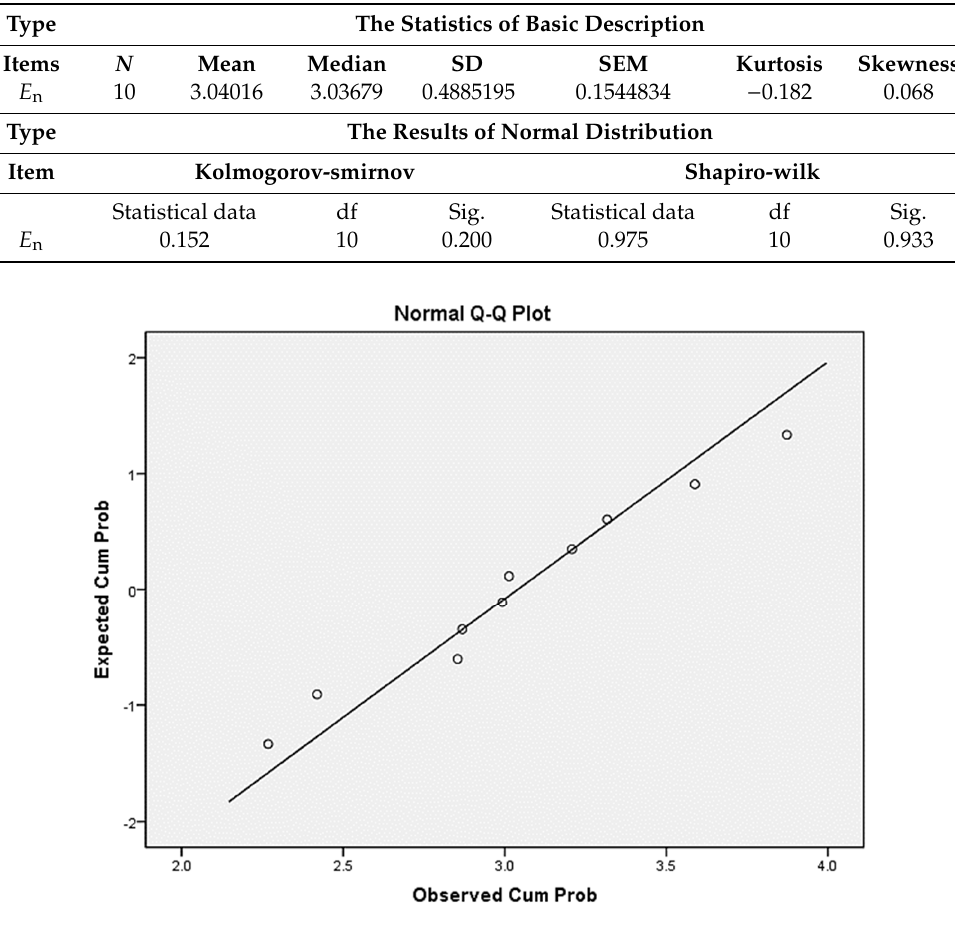
Figure 7. Normality test Q-Q diagram.